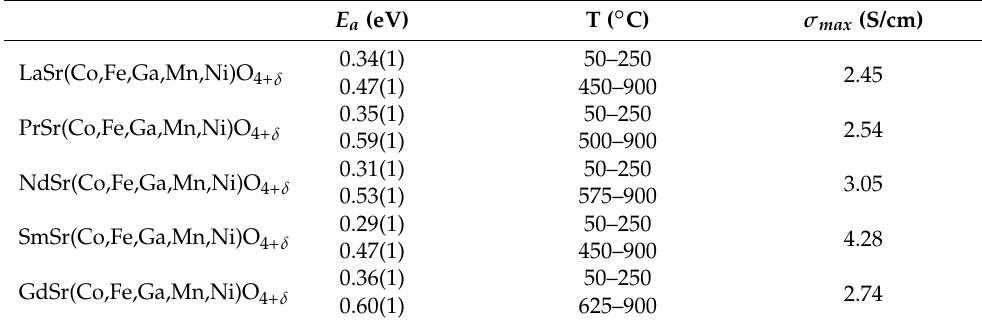
Table 3. The determined values of energy of activation for the LnSr(Co,Fe,Ga,Mn,Ni)O 4+ δ series (Ln = La, Pr, Nd, Sm, or Gd). The maximum value of total conductivity is also provided. E a (eV)